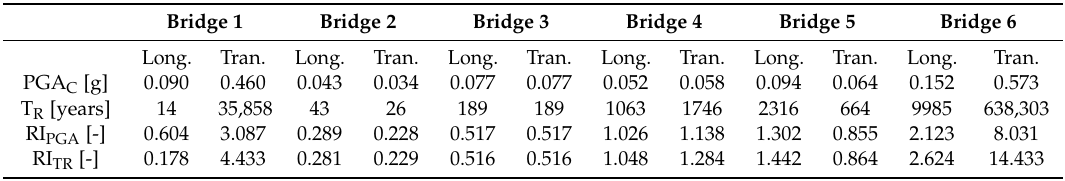
Table 5. Risk indexes for ductile mechanism. Table 6. Risk indexes for brittle